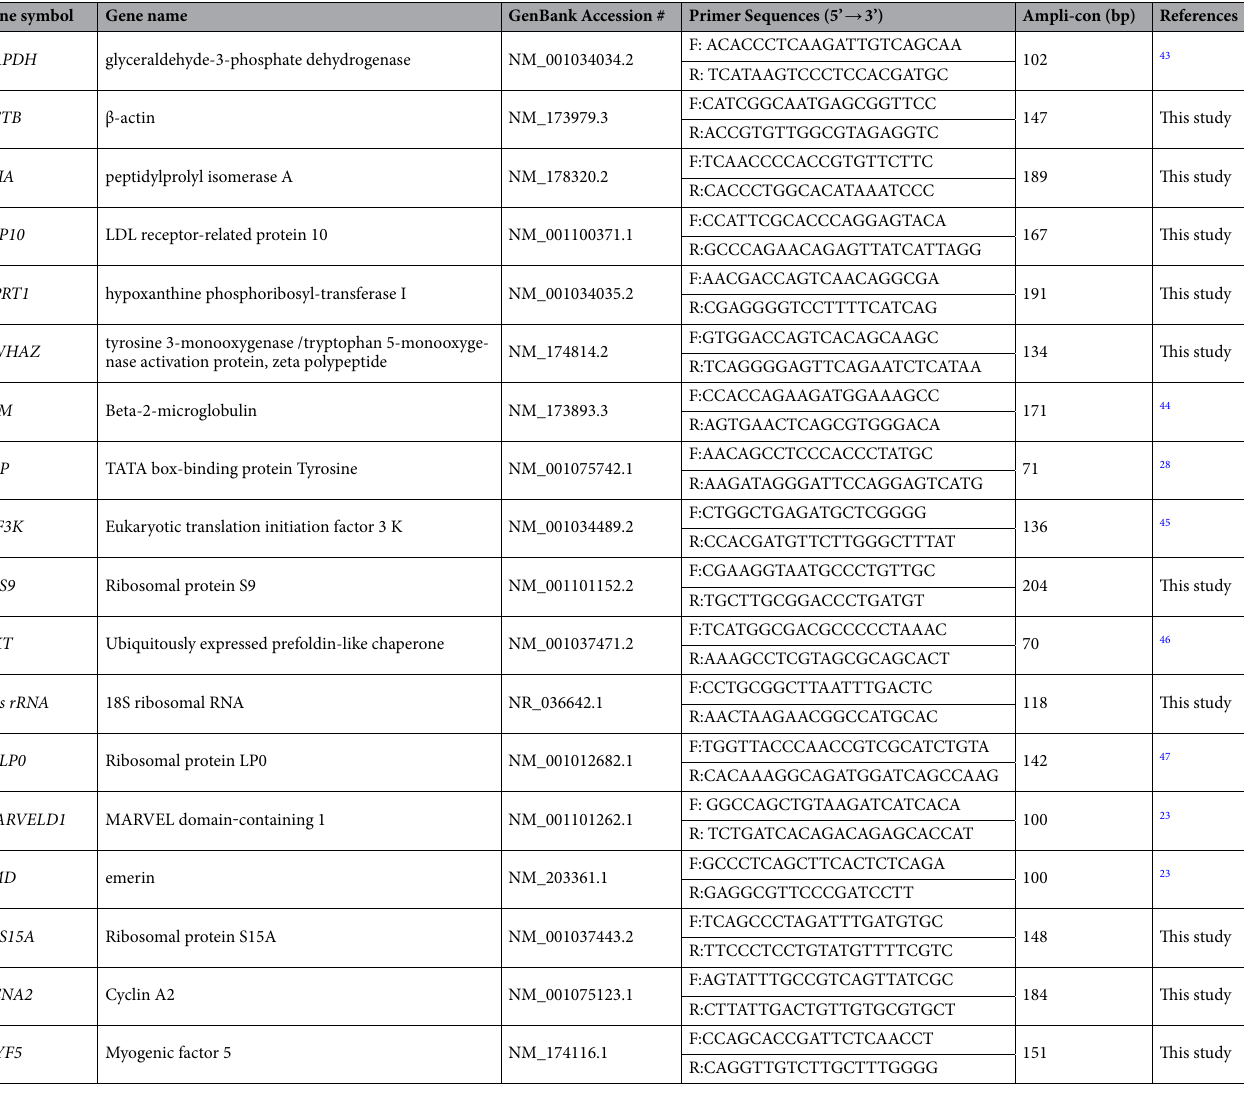
Table 5. Primer sequences for